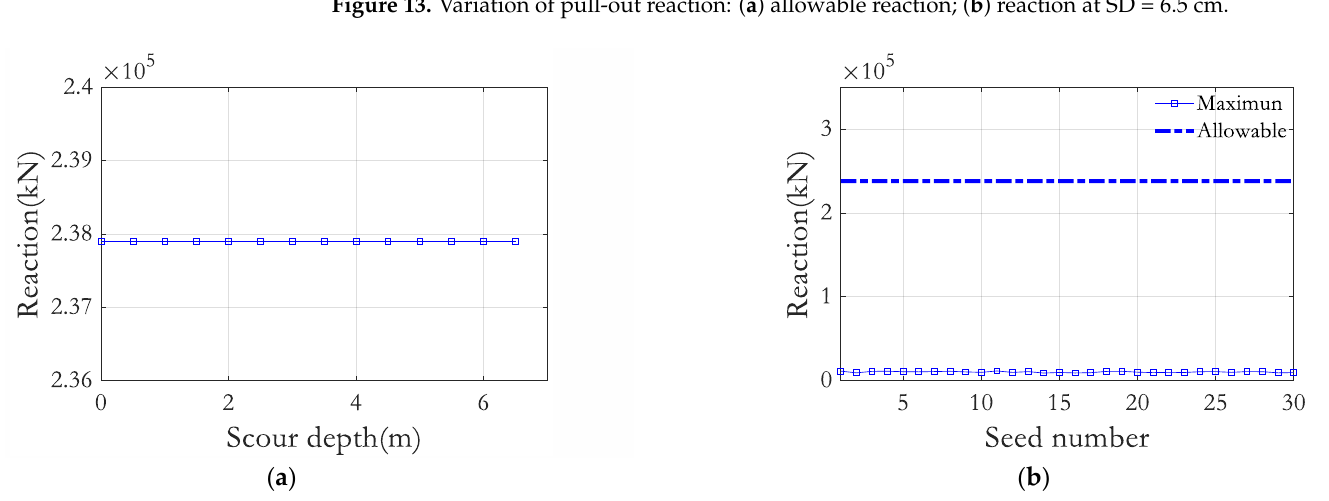
Figure 14. Variation of compressive reaction: ( a ) allowable reaction; ( b ) reaction at SD = 6.5 cm.